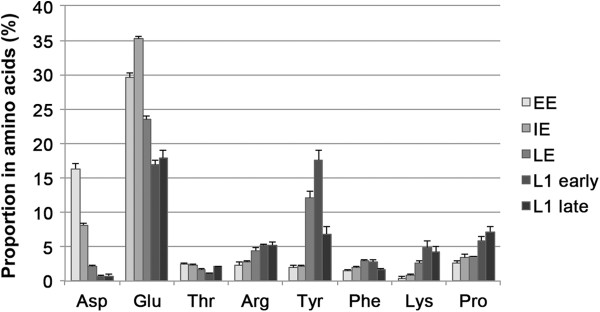
Proportion of free amino acids during pea aphid development. Free amino acid contents of early, intermediate and late embryos, and in the first larval stage taken at two distinct times of development (early L1 ≤ 6 hours and late L1 ≥ 13 hours). Values (n = 4) are expressed as a percentage of the total amount of amino acids in the different samples. Among the 18 amino acids analysed, only those varying the most (P < 0.0001) and phenylalanine (P = 0.0015), the precursor of tyrosine, are represented. In particular among the significant changes (see Table S8 for details) it is worth noting: a decrease of aspartic acid from 16.3% in the early embryos (EE) to 0.7% in L1 larvae; a glutamic acid decrease from IE (35.2%) to the L1 stages (around 17.4%); an accumulation of tyrosine during development from 1.9% in early embryos (EE) to 12.1% in the late embryo group (LE), accumulation that continues in early first larval stage (17.6%) to decrease rapidly to 6.8% for the late larvae L1.